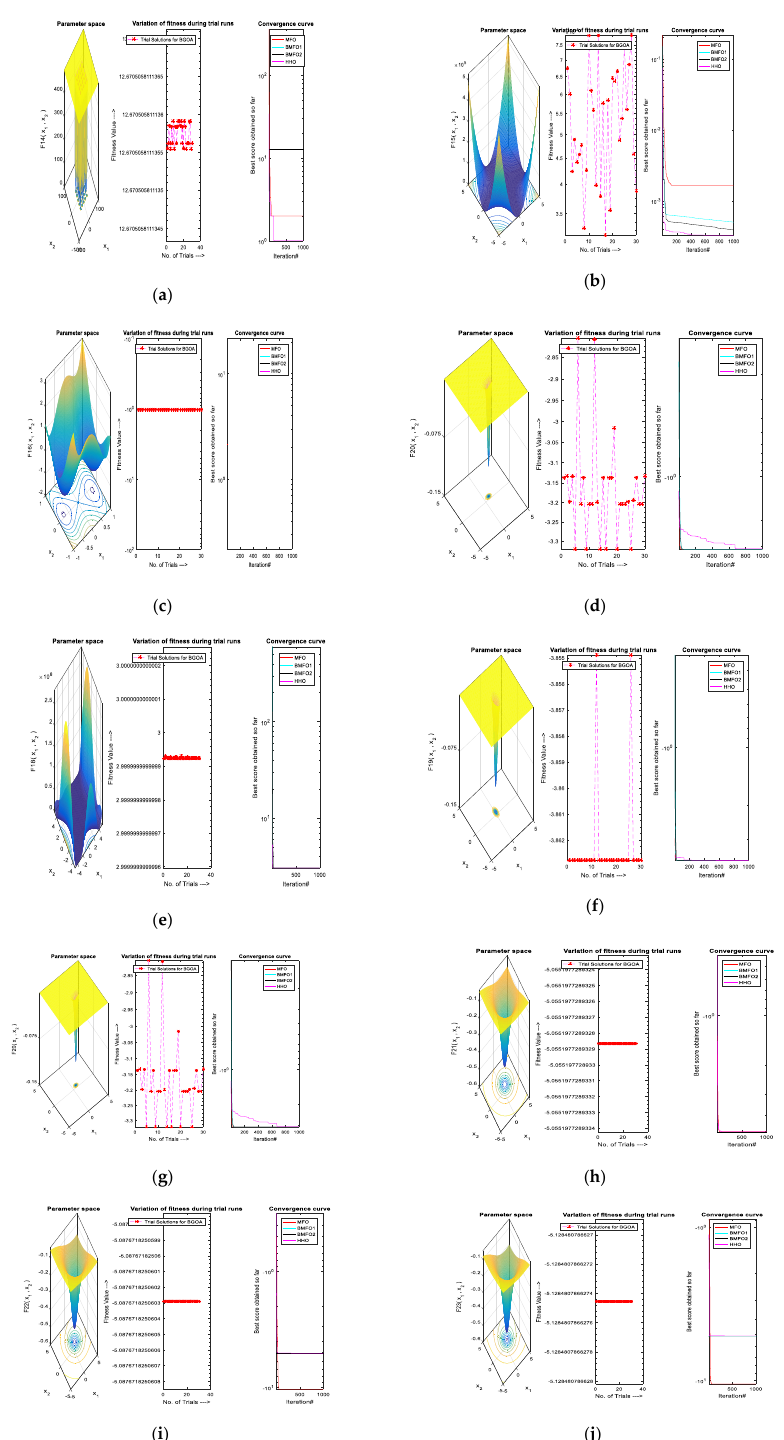
Figure 7. ( a – j ) . Convergence curve and trial solution of BMFO2 for fixed dimension benchmark Figure7. ( a – j functions. The comparative outcomes for fixed dimension benchmark [91] functions have been represented in Tables 9 and 10, which are associated with other latest refined met heuristics search algorithms [54,92] GWO [62], PSO [63,64], GSA [8,65], DE [66,67], FOA [68,69], ALO [70,71], SOS [72], BA [73], FPA[74,75], CS [76], FA [52], GA [77], GOA [73,78], MFO [79], MVO [80], DA [81], BBA [65], BBO [5,82], BGSA [83,84], SCA [85,86], FPA [74,87], SSA [88], and WOA [89] in terms of standard deviation [93] and average. Table 9. Comparison of fixed dimension benchmark functions.